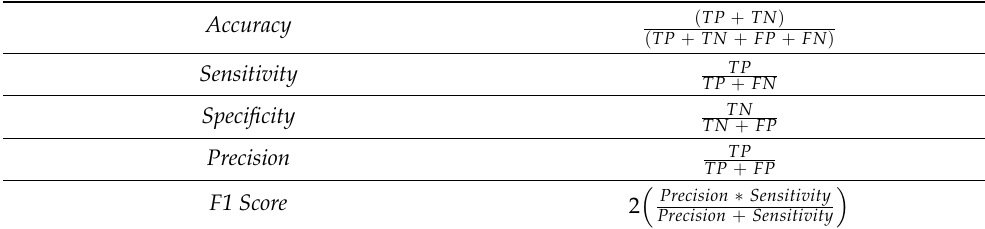
Table 2. Performance evaluation metrics.